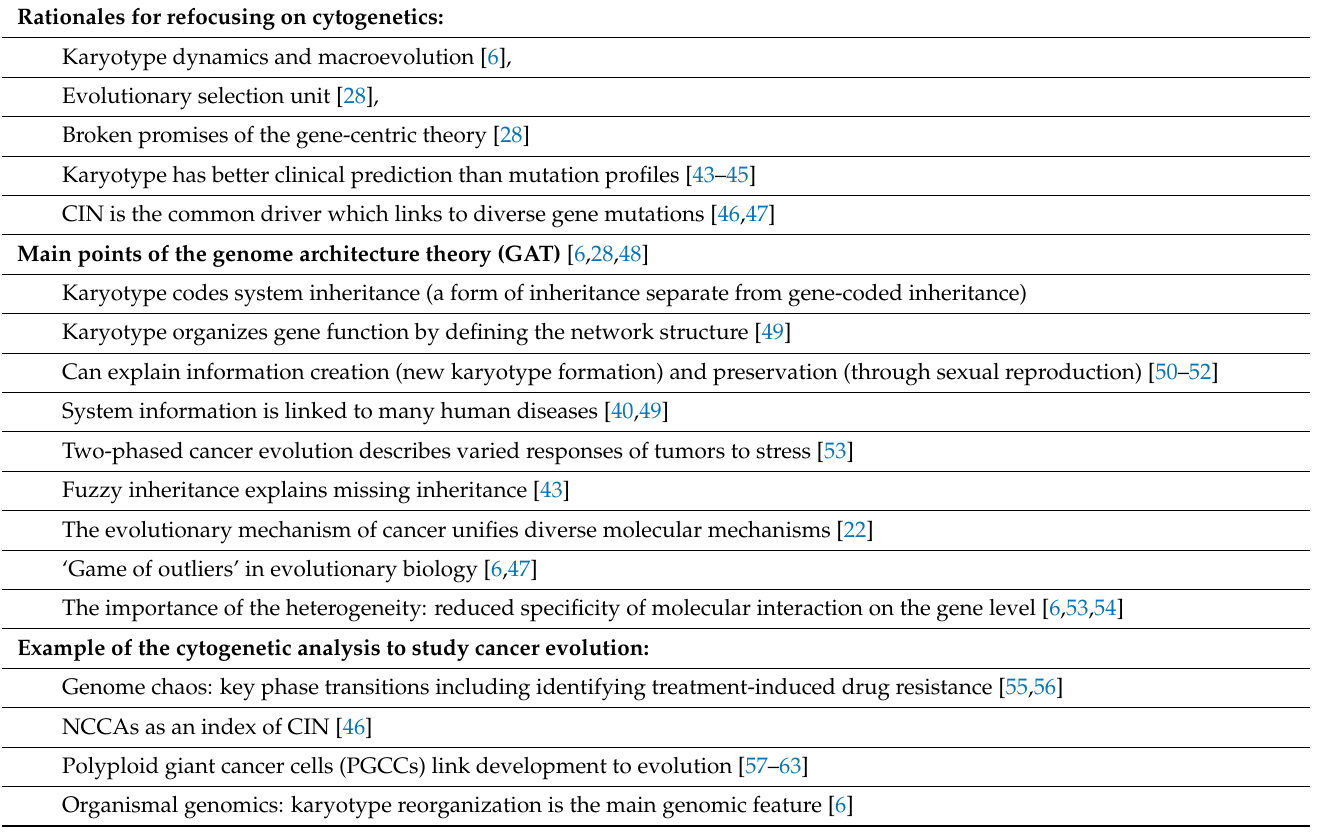
Table 1. Genome Architecture Theory: examples of the rationales, the points, and case